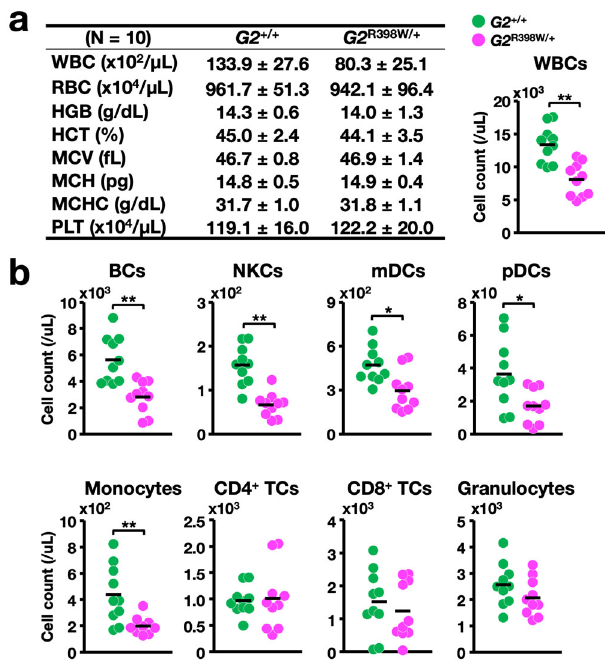
Fig. 3 Evaluation of the peripheral blood counts of 12-month-old G2 R398W/ + mice. a Summary of hematopoietic indices. A dot plot of WBC counts in the peripheral blood of G2 + / + and G2 R398W/ + mice is shown in the right panel. b Dot plots of the cell counts of the indicated cell populations of G2 + / + and G2 R398W/ + mice. * p < 0.05, ** p < 0.01. N = 10 of each genotype.